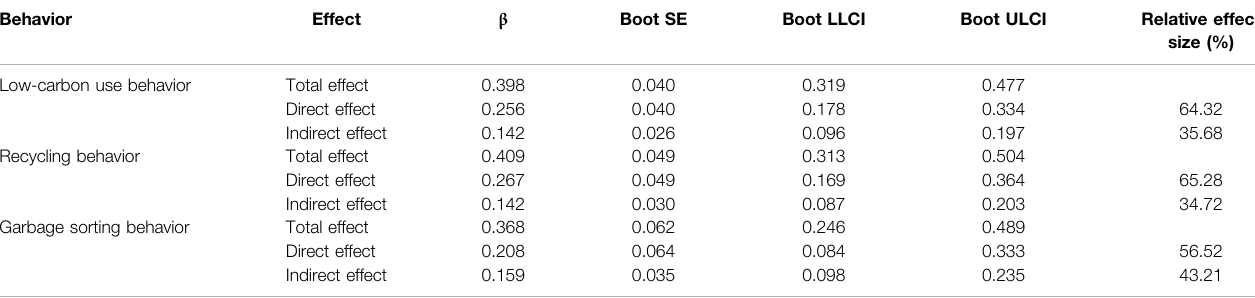
TABLE 7 | Direct and mediating effects of environmental self-identi fi cation.